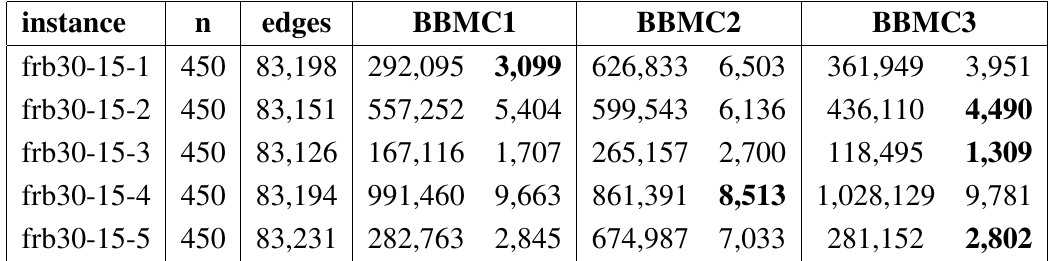
Table 5. BHOSLIB using BBMC: 1,000’s of nodes and run time in seconds. Problems have 450 vertices and graph density